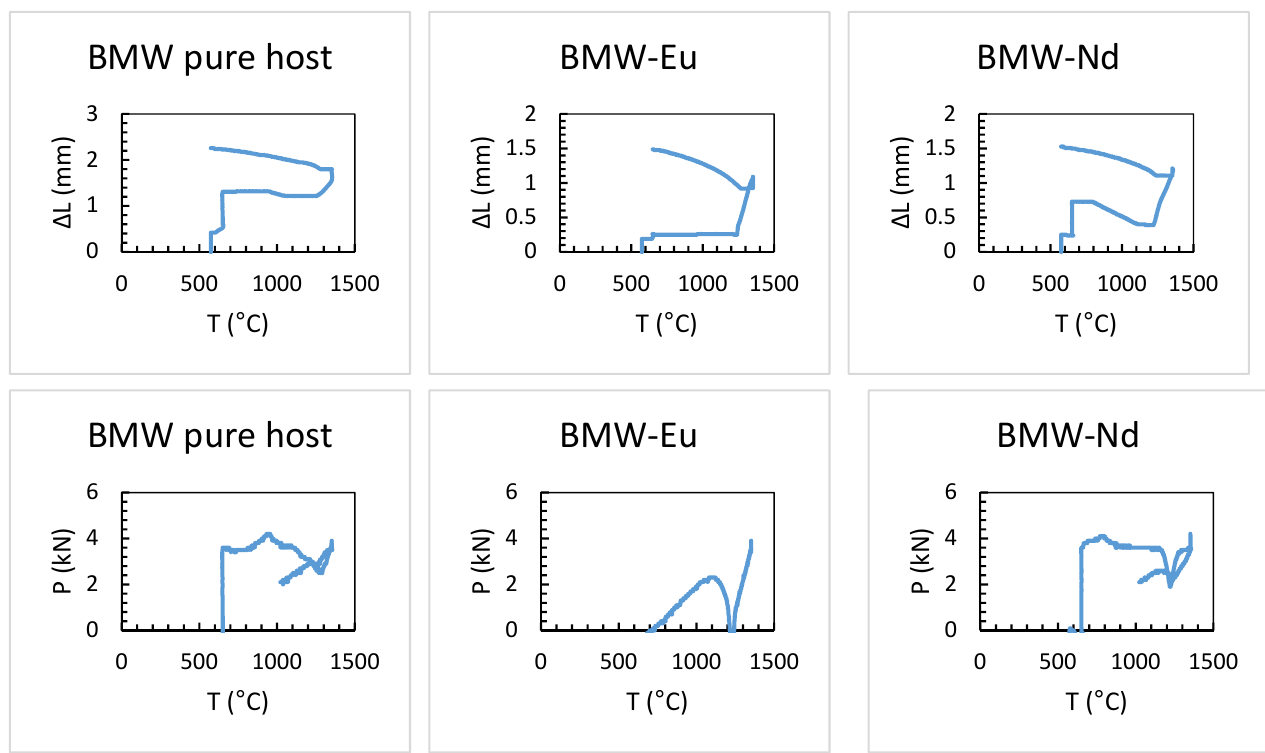
Figure 4. Sintering profiles of double perovskites of Ba 2 MgWO 6 in function of temperature, where P is pressure and ∆ L is shrinkage.